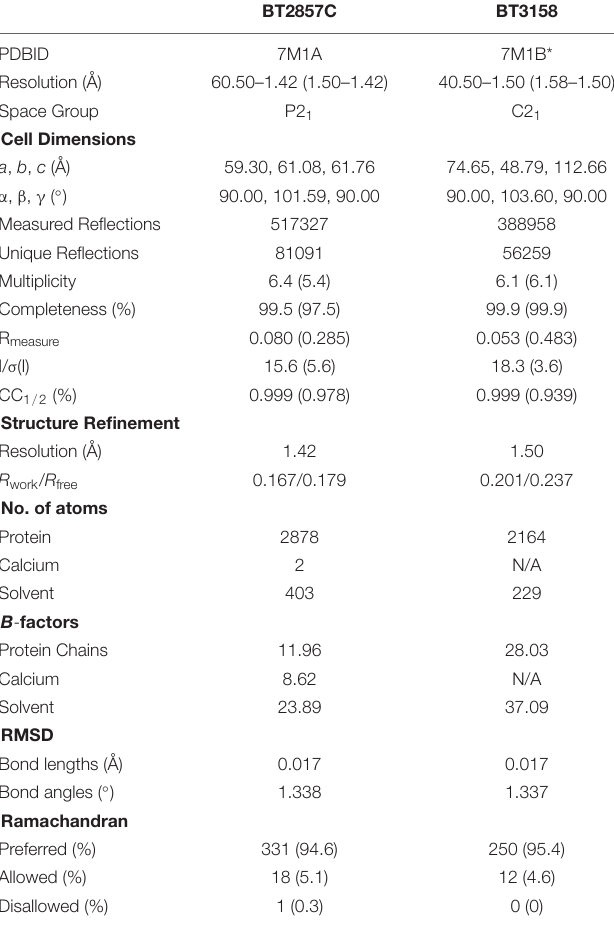
TABLE 1 | Diffraction data collection and structure refinement statistics.